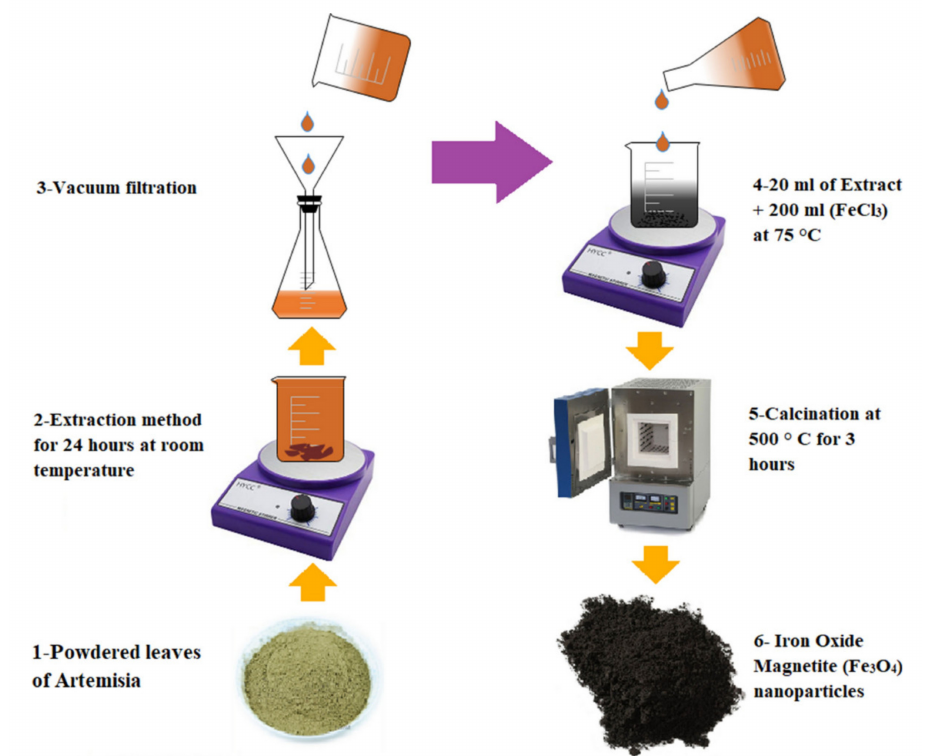
Figure 4. Green synthesis for Fe 3 O 4 nanoparticles, copied with permission from Ref. [36], Springer- Nature,